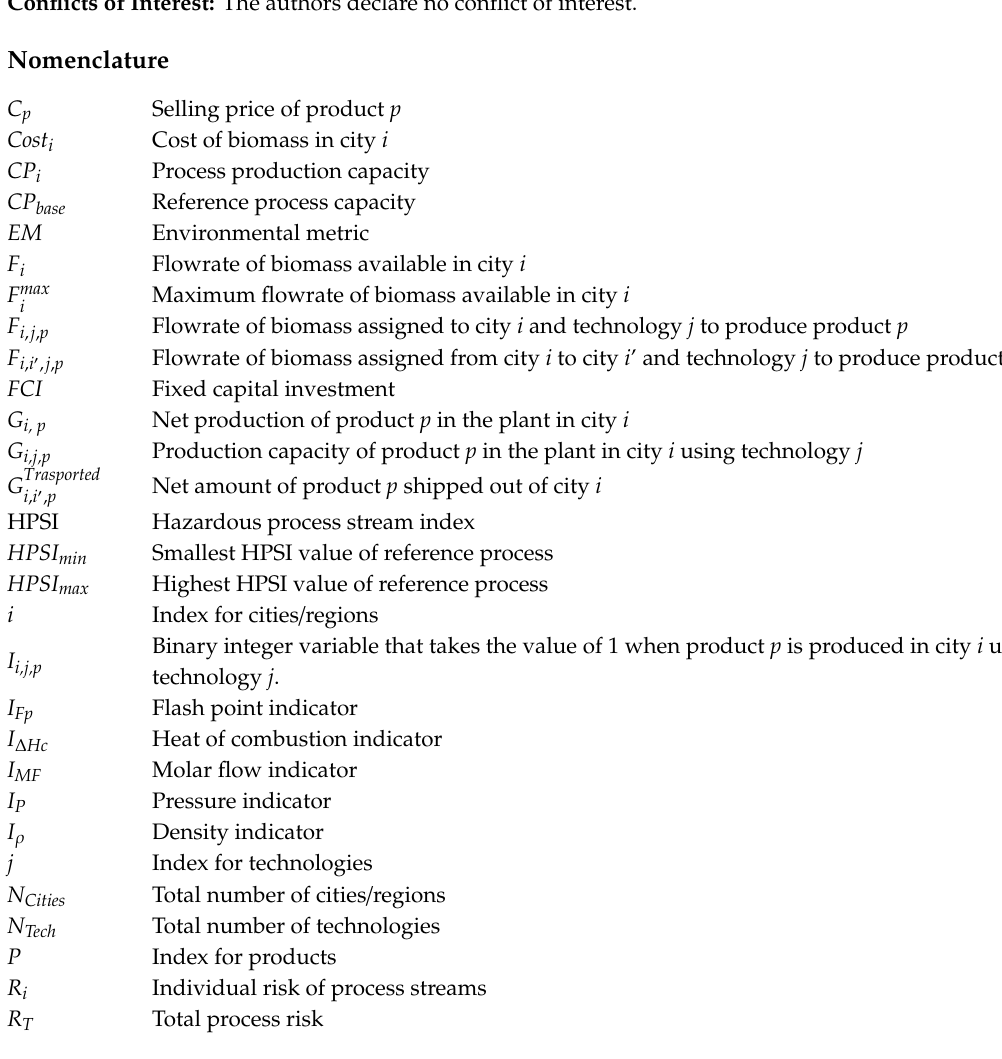
Figure S1: Data used in developing FCI correlation, Table S1: Summary of extracted